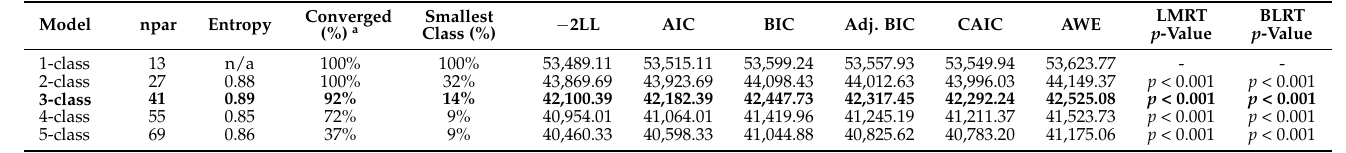
Table 3. Latent Class Analysis (LCA) Model Fit